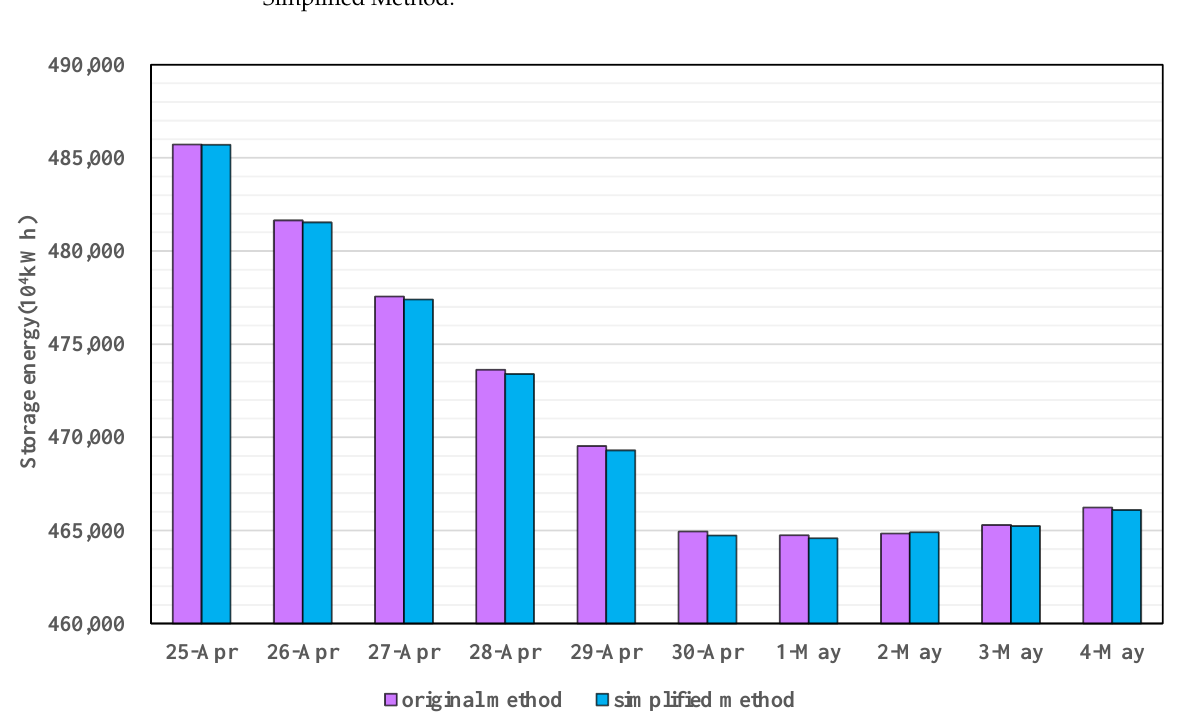
Figure 4. Storage Energy Process of Cascaded Hydropower System Obtained by Original Method and Simplified Method.